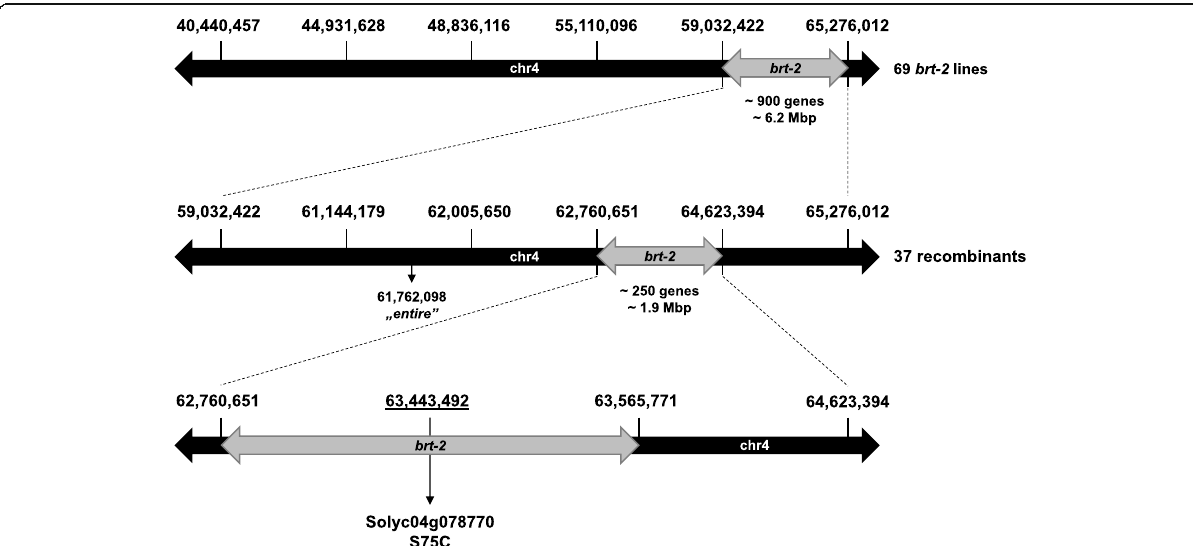
Fig. 3 Schematic summary of the genetic mapping process of brt-2 locus. The SL2.50 positions (bp) of SNP/InDel used for KASP marker design are indicated. The position of “ entire ” mutant (cytosine deletion) in the closely linked SLAA9 gene is marked. The position of brt-2 causative mutation is underlined and resulting amino acid change is presented